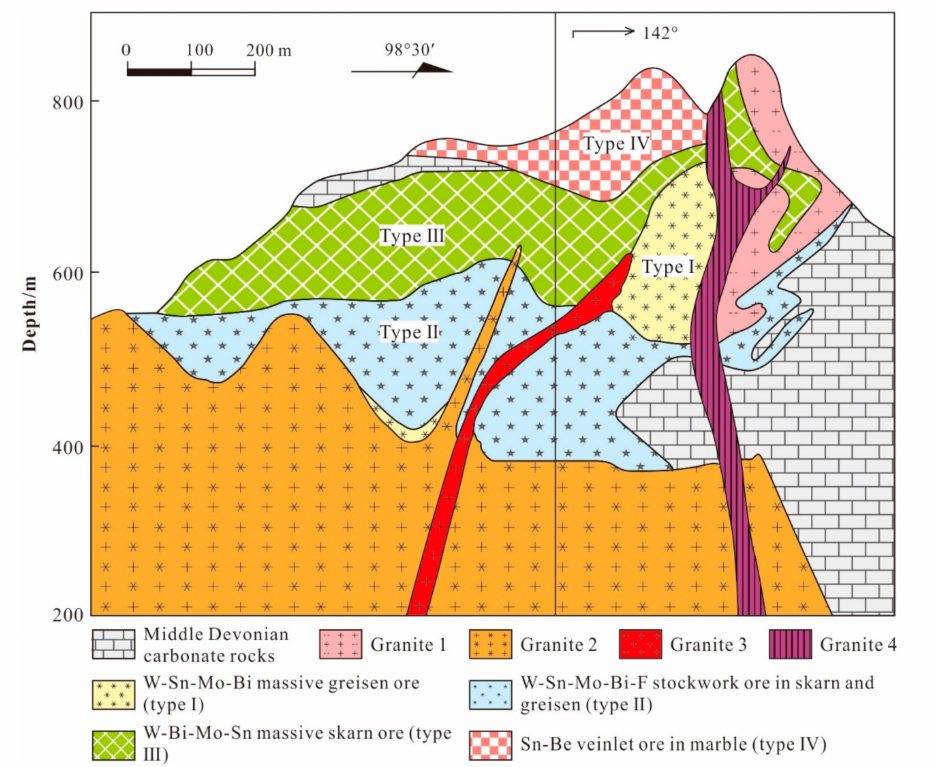
Figure 3. Drill core profile of the Shizhuyuan W-polymetallic deposit showing the position of the four main ore types (modified after Zhao et al. [7] and Lu et al.